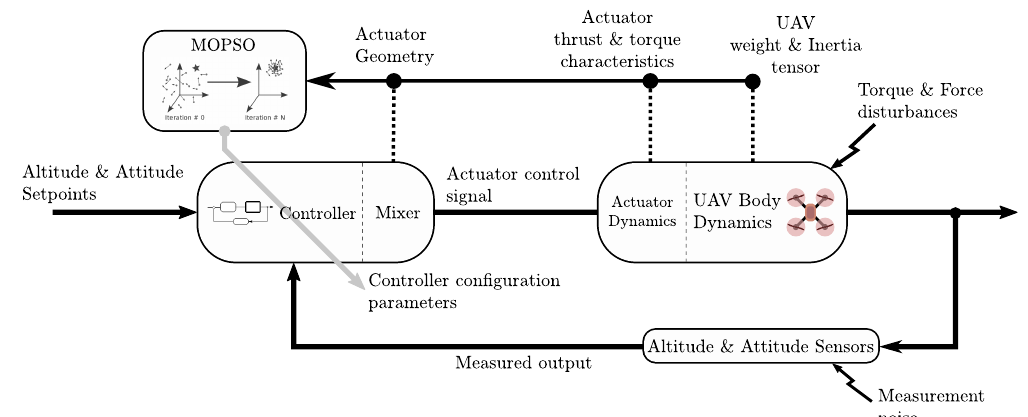
Figure 5. Altitude and attitude control of a Px4-based UAV with optimal PID computed offline by the proposed MOPSO algorithm.